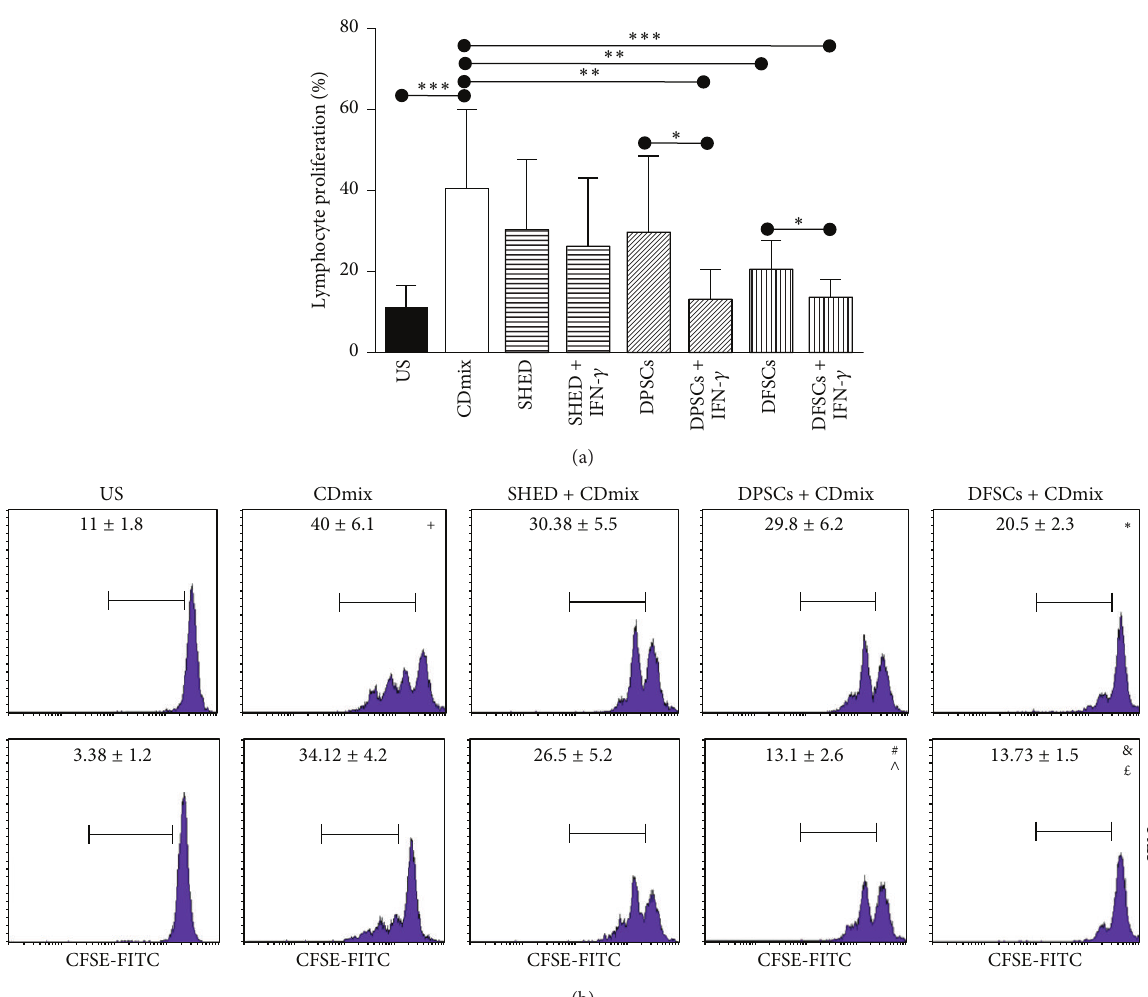
Figure 5: Inhibitory effect of SHED, DPSCs, and DFSCs on the proliferation of lymphocytes as detected by CFSE. (a) Inhibitory effect of SHED, DPSCs, and DFSCs on the proliferation of lymphocytes displayed statistically. (b) Inhibitory effect of SHED, DPSCs, and DFSCs on the proliferation of lymphocytes displayed by flow cytometry. + 𝑃 < 0 . 001, compared with US group. ∗ 𝑃 < 0 . 01, compared with CDmix group. # 𝑃 < 0 . 05, compared with DPSCs + CDmix group. & 𝑃 < 0 . 05, compared with DFSCs + CDmix group. ∧ 𝑃 < 0 . 01, compared with CDmix group. m 𝑃 < 0 . 001, compared with CDmix